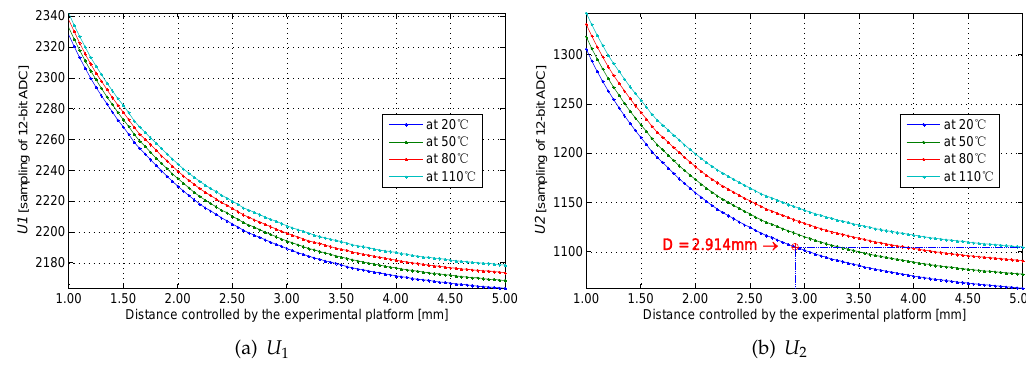
Figure 21. ADC samples U 1 and U 2 at different